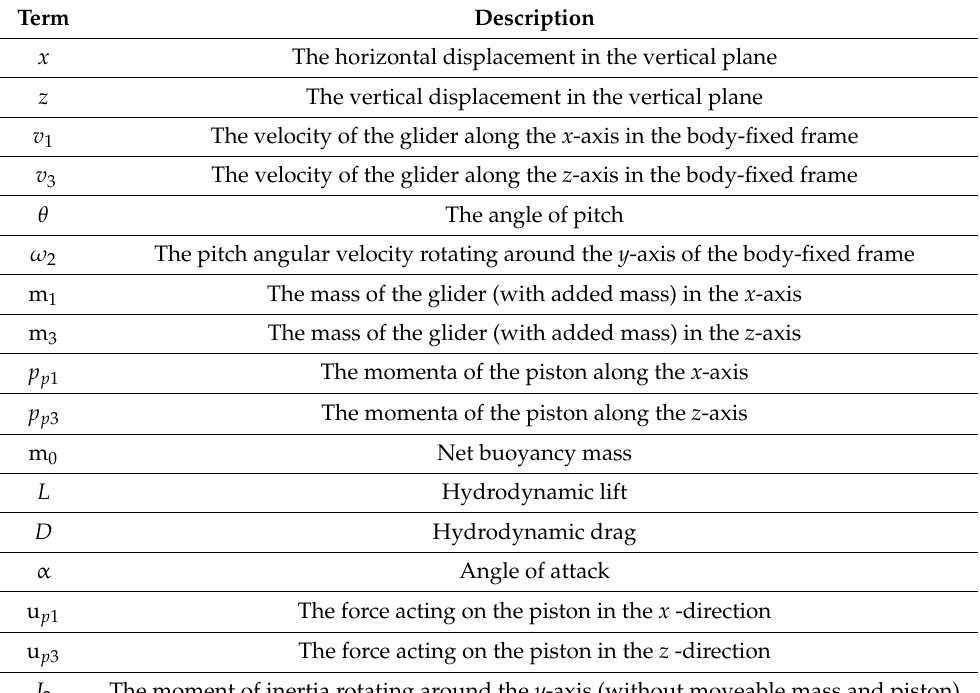
Table 1. Descriptions of parameters of the above equations.